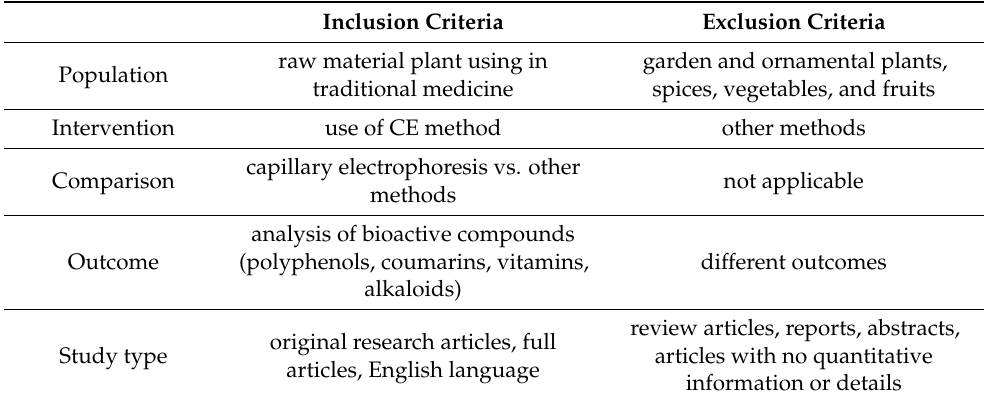
Table 9. PICOS (Population, Intervention, Comparison, Outcome, Study